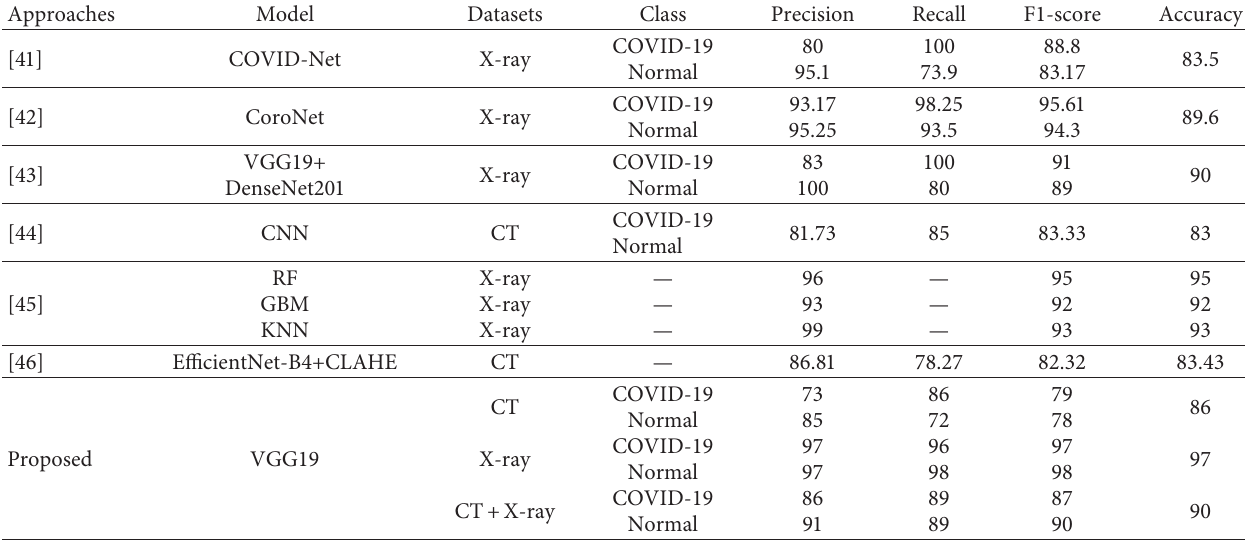
Table 8: Performance comparison of the proposed VGG19 model with the state-of-the-art approaches.